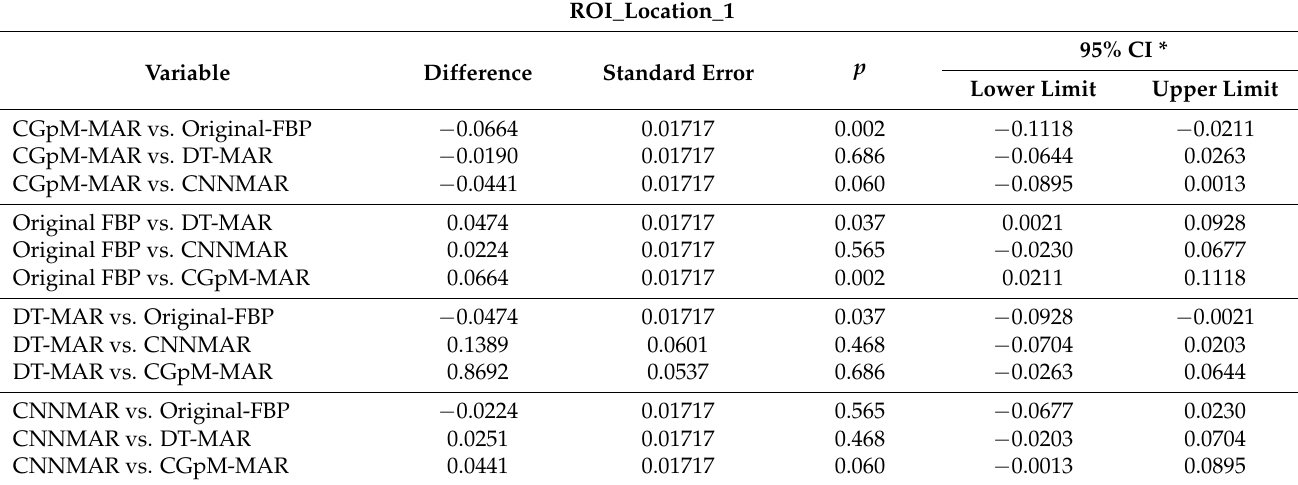
Table 1. Metal artifact reduction performances of tomosynthesis reconstruction algorithms. (streak artifact